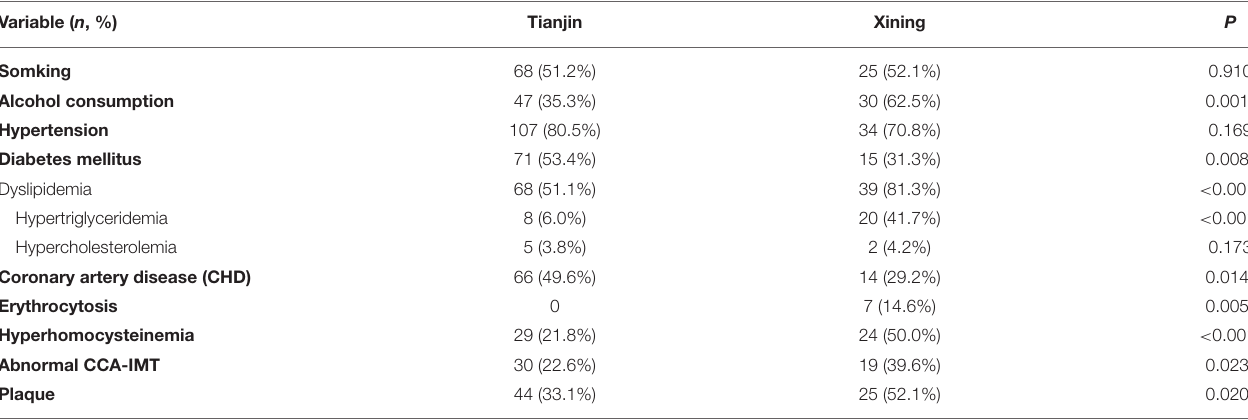
TABLE 2 | Risk factors with acute ischemic stroke at different